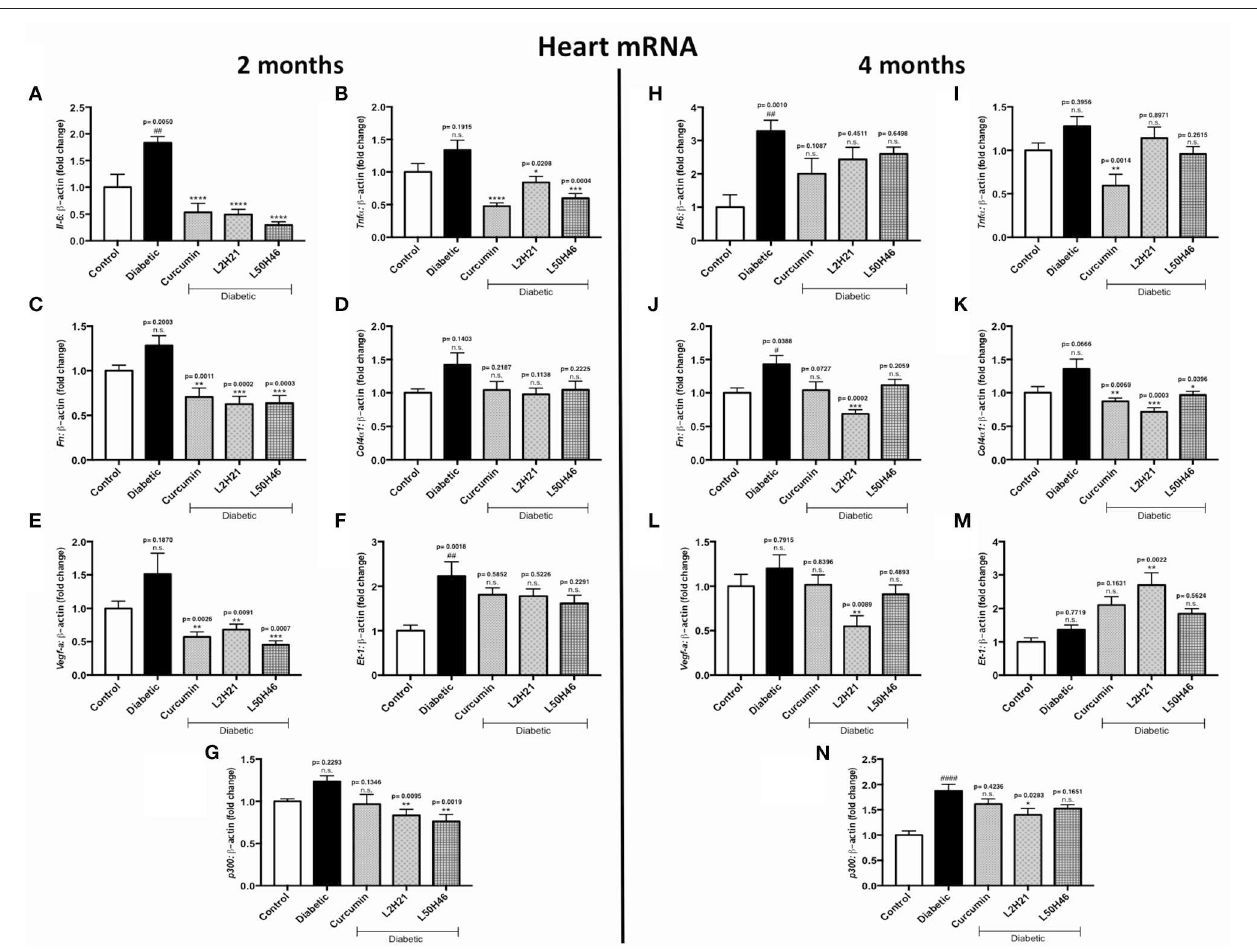
FIGURE 5 | Effects of curcumin and its analogs on cardiac transcripts at 2 and 4 months. Left panel: RT-qPCR analyses showing increased mRNA levels of (A) Il-6 , (B) Tnf- α , (C) Fn , (D) Col4 α 1 , (E) Vegf-a , (F) Et-1 , and (G) p300 in the cardiac tissues of diabetic mice at 2 months. Administration of curcumin, L2H21, or L50H46 produced differential expressions of these transcripts in the cardiac tissues of diabetic mice. Right panel: RT-qPCR analyses of (H) Il-6 , (I) Tnf- α , (J) Fn , (K) Col4 α 1 , (L) Vegf-a , (M) Et-1 , and (N) p300 in cardiac tissues at 4 months. Treatment with curcumin or its analogs at this time point produced differential RNA expressions [data expressed as a ratio to β -actin (mean ± SEM); normalized to Control; # significance between Control vs. Diabetic; *significance between Diabetic vs. Treatment group; * , # P < 0.05, ** , ## P < 0.01, *** , ### P < 0.001, and **** , #### P < 0.0001; n = 6 animals/group; n.s., not significant; Control = non-diabetic controls; data analyzed by ANOVA followed by Tukey’s post-hoc